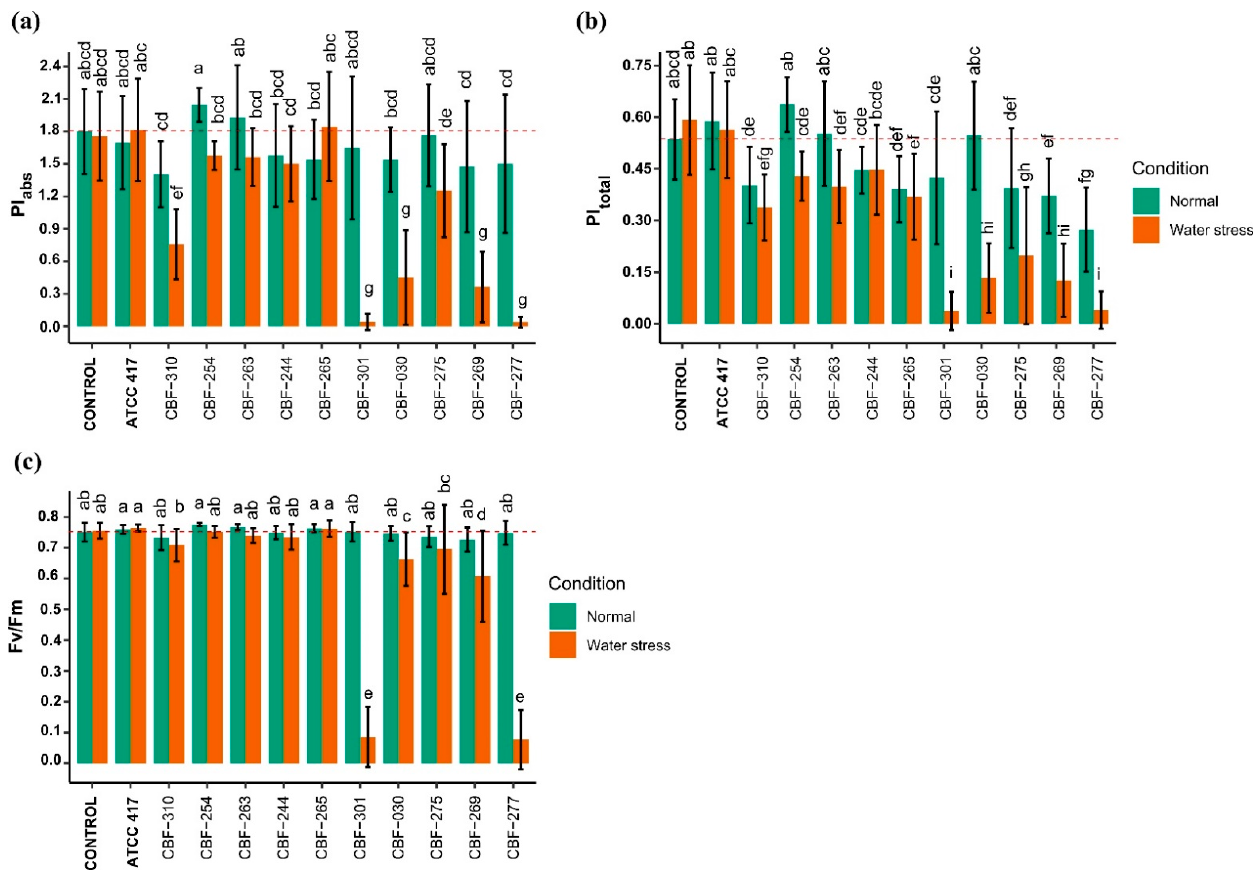
Figure 4. Effects of Fusarium isolates on photosynthetic activity indicators. ( a ) PI abs ; ( b ) PI total ; ( c ) Fv/Fm. Data points represent mean ± SD of at least twenty measurements of ten coffee plants. Treatments sharing one or more letters indicate are not significantly different ( p < 0.05). Red dotted lines indicate control